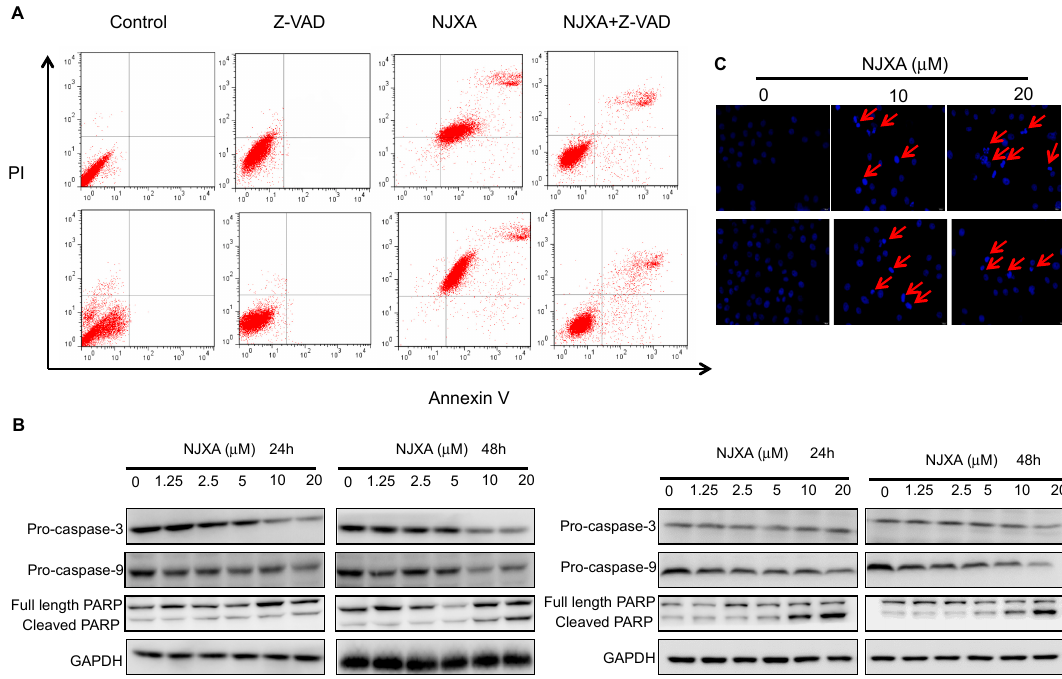
Figure 2. NJXA triggers apoptosis in HeLa and SiHa cells. ( A ) Annexin V/PI flow cytometric analysis of NJXA-treated HeLa (upper panel) and SiHa (lower panel) cells. Cells pre-treated with z-VAD-fmk for 2 h were then treated with or without NJXA (20 μ M) for 24 h. The cells were then collected and were double-stained with a FITC-conjugated anti-Annexin V antibody and PI. The analyses were performed using a flow cytometer; ( B ) Western blotting analysis showed caspase-3 and caspase-9 activation and PARP cleavage in HeLa ( left panel ) and SiHa ( right panel ) cells treated with NJXA; ( C ) Hoechst 33342 staining showed DNA condensation and fragmentation after NJXA treatment of HeLa ( upper panel ) and SiHa ( lower panel ) cells.